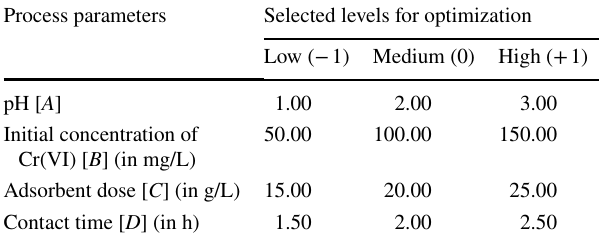
Table 4 Selected levels of process parameters used in optimization through three level central composite design Process parameters Selected levels for optimization